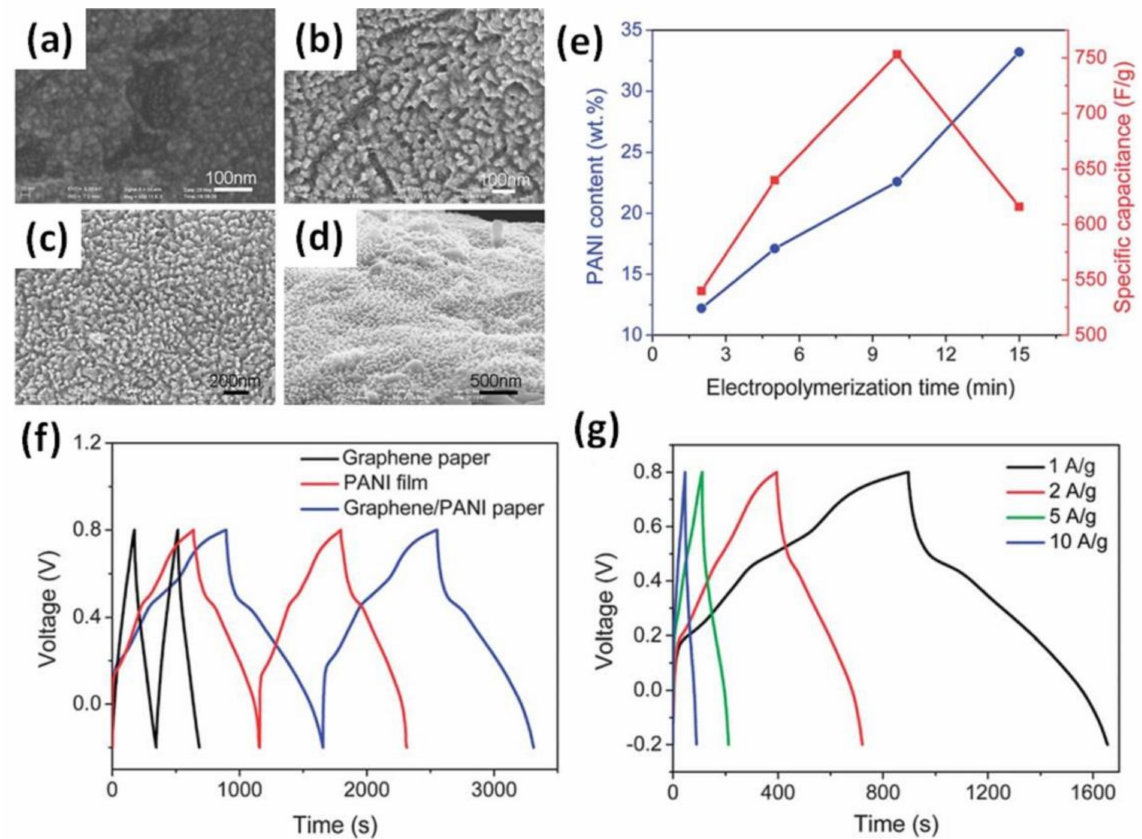
Figure 12. Microstructures of the surface of the graphene/PANI composite papers with EP times of: 2 min ( a ), 5 min ( b ), 10 min ( c ) and 15 min ( d ). Changes of weight content of PANI in the graphene–PANI papers and the corresponding specific capacitances with EP time ( e ). Galvanostatic charge–discharge curves of graphene paper, PANI film on the Pt electrode and graphene–PANI paper at a current density of 1 A/g ( f ) and GCD curves of graphene–PANI paper at different current densities ( g ) (Reprinted from [45] with permission of RSC